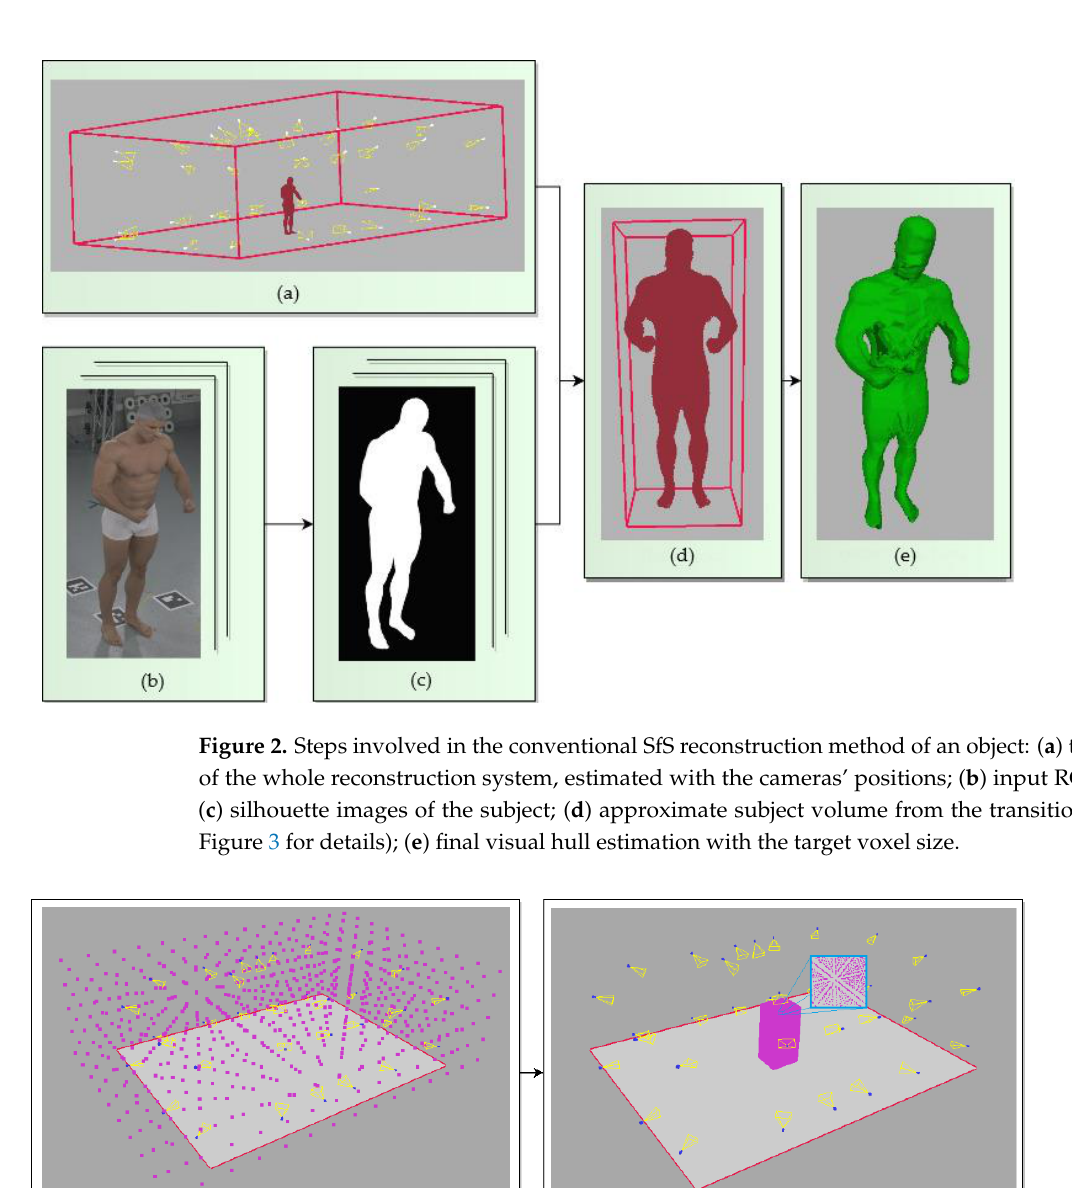
Figure 4. Example of Omnimatte [61] silhouette estimation performance with voxel projections onto the image (data sample #9): ( a ) input RGB image; ( b ) silhouette image with magnified silhouette quality values on its edge; ( c ) voxel center projections onto the silhouette. The projections in the image are marked with pixel-sized dots. The blue pixels represent the silhouette, and the red repre- sent the background.